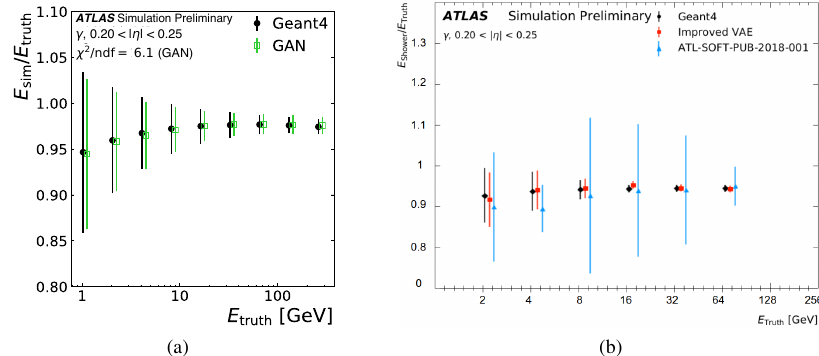
Figure 3. (a) Energy response of the calorimeter as a function of the true photon energy for particles with 0 . 20 < | η | < 0 . 25. The calorimeter response for G eant 4 is shown in black full markers used as reference and is compared to the one from the generative adversarial network (GAN), shown in green open markers. The GAN is shown with a small artificial shift towards the right for better visibility. The error bars indicate the resolution of the simulated energy deposits. From Ref. [16]. (b) Energy response of the calorimeter as function of the true photon energy for particles in the range of 0 . 20 < | η | < 0 . 25 comparing G eant 4 (black circles), the baseline VAE model (Ref. [15]) (cyan triangles) and the new improved VAE model (red squares). The shown error bars indicate the resolution of the simulated energy deposits. For clarity, a small o ff set is applied to the di ff erent simulation choices. From Ref.